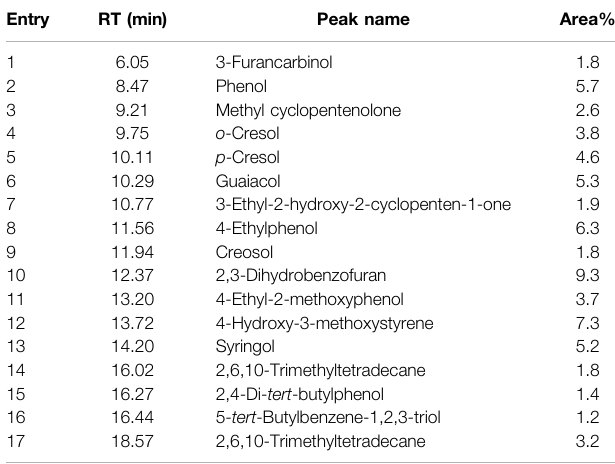
TABLE 3 | Relative proportion (area%) of most components of corn stalk – based bio-oil at 1000